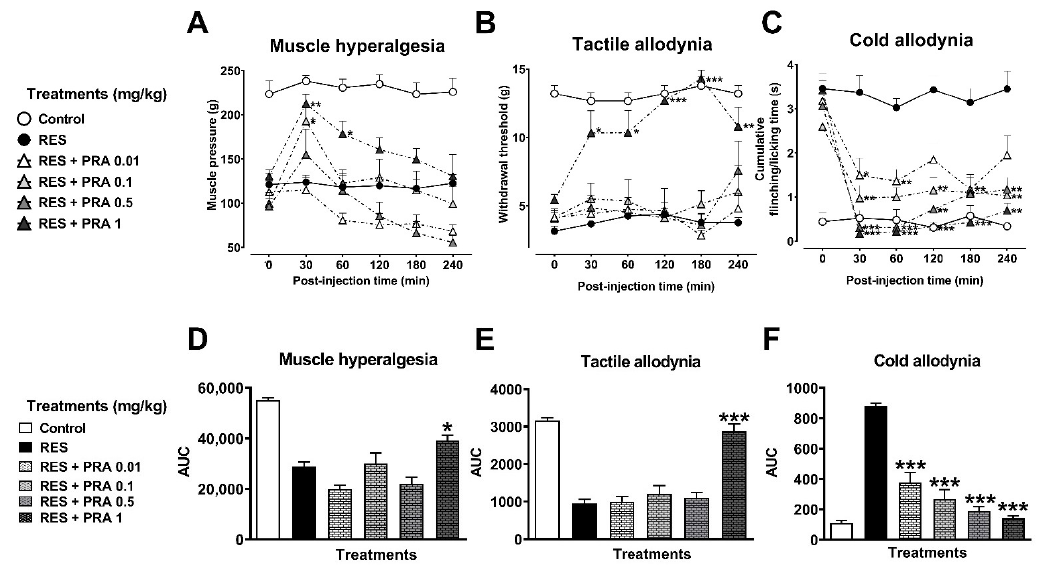
Figure 7. Antihyperalgesic and antiallodynic effect of pramipexole (PRA) on the reserpine (RES)- induced nociceptive threshold. Time-course curves of the threshold to muscle pressure, shown as the force in grams supported in the right gastrocnemius muscle ( A ), the tactile response, shown as the force in grams supported on the plantar surface of the right hind limb ( B ), and cold allodynia, shown as the cumulative response time to cold stimulus (acetone) on the dorsal surface of the right hind limb for 1 min ( C ). Area under the curves of the muscle pressure threshold ( D ), tactile response ( E ), and cold allodynia ( F ). One-way ( D – F ) or two-way ( A – C ) ANOVA followed by Tukey’s test, * p < 0.05, ** p < 0.01, *** p < 0.001 vs. RES group.